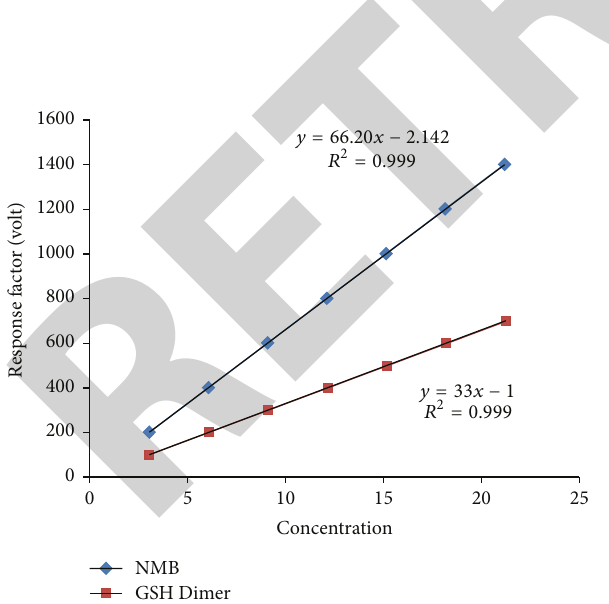
Figure 4: Linearity plot of 2-nitro-5-mercapto-benzoic (NMB) acid and glutathione dimer (GSH Dimer).